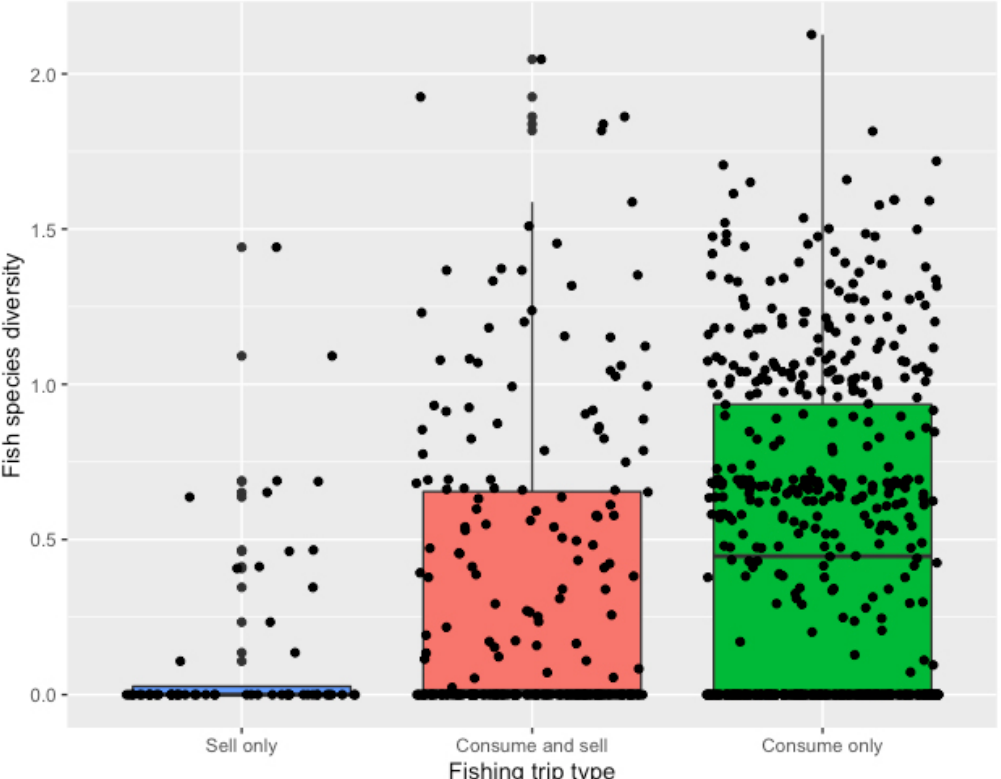
FIGURE 5 | Fish species diversity caught by rural artisanal fishers on the Rio Purus. Fishing catches to be sold were less diverse than those to be consumed. Trips were classified based on whether the stated intention by the fisher was to sell, for household consumption or both. The Shannon’s diversity index, calculated per fishing trip, is shown.